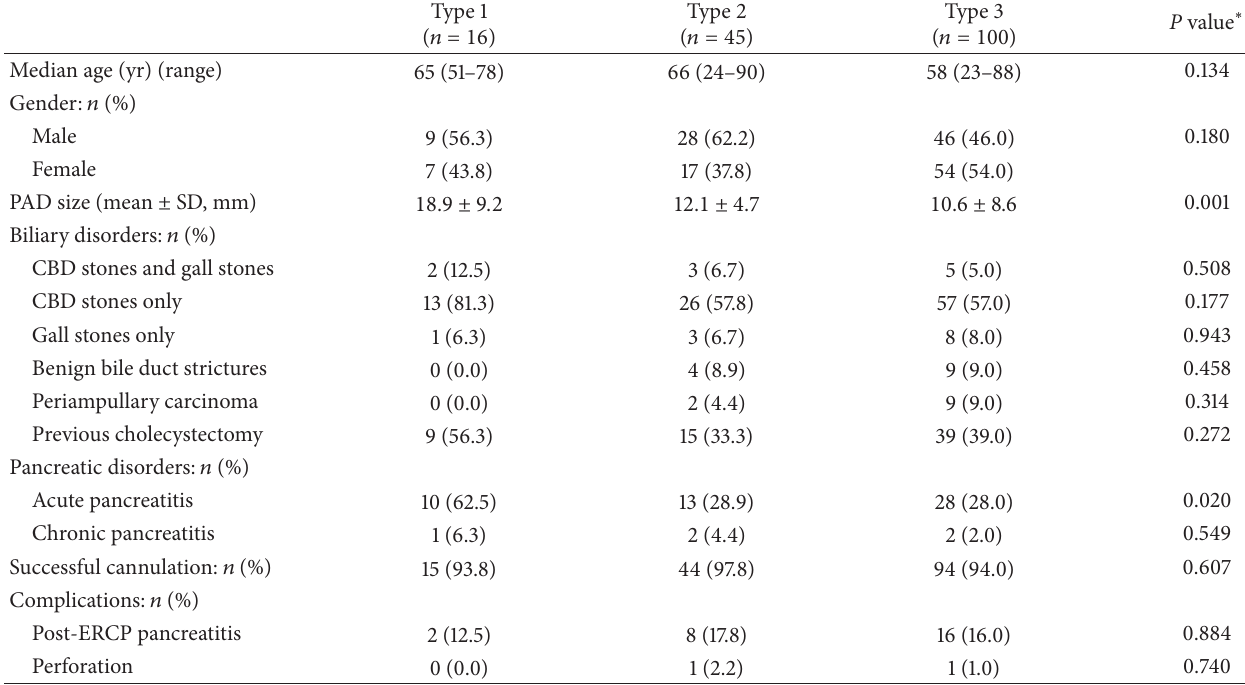
Table 2: Cholangiopancreatic disorders and technical success of ERCP in different PAD